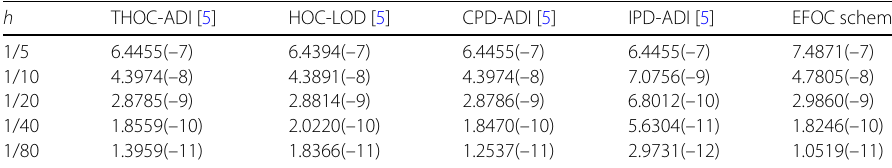
Table 3 The L 2 norm error with τ = 0.0025 at t = 1 for Problem